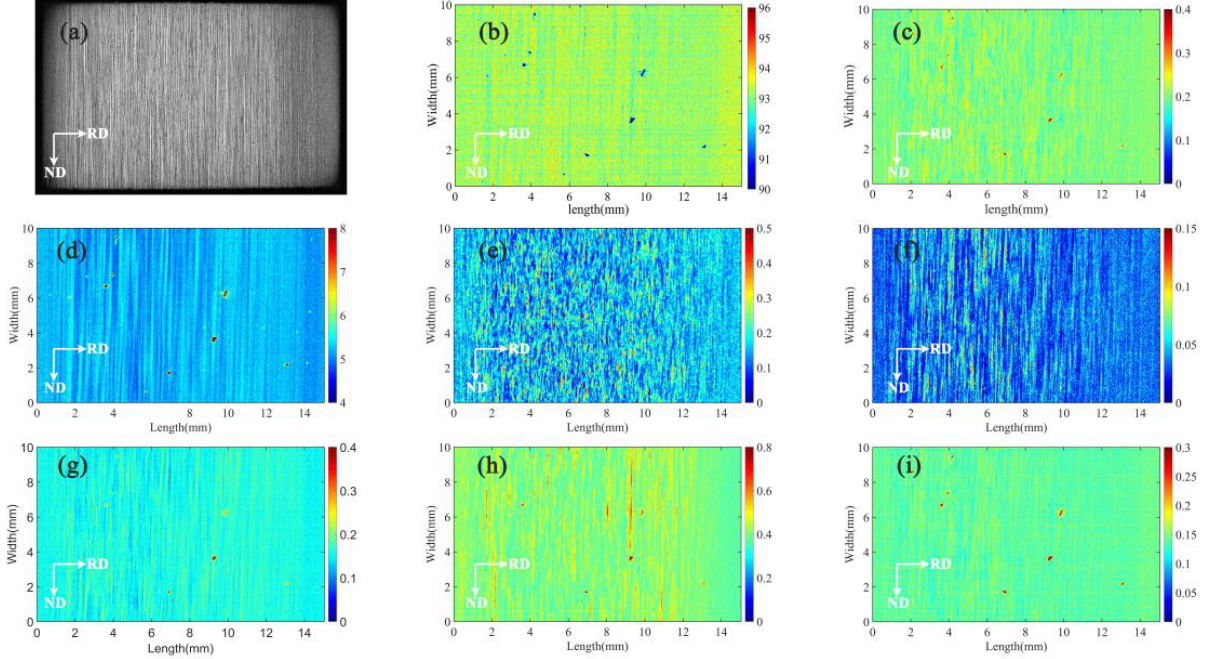
Figure 7. Two-dimensional distribution map of element content in 7B05 aluminum alloy; ( a ) metallographic structure after corrosion, ( b ) Al, ( c ) Cr, ( d ) Zn, ( e ) Fe, ( f ) Ti, ( g ) Cu, ( h ) Mn, and ( i ) Zr. In accordance with the GB/T24213-2009 on general rules of original position statistics, the content distribution analysis of each element at different positions obtained from the surface distribution was carried out. Statistical parameters such as the degree of segregation degree, statistical segregation degree, and segregation ratio of each element in the entire scanning area are obtained. For values of S and SRx, refer to Equations (1) and (3). Values of DS Positive and DS Negative correspond to confidence intervals of 97.5% and 2.5%, respectively, referring to Equation (2). The results are shown in Table